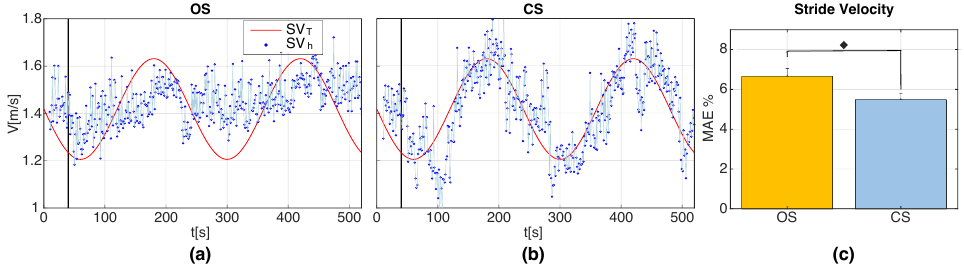
Figure 9. ( a , b ) SV h for a representative participant for the two stimulation methods, OS and CS, during S3. The black vertical line represents the time at which the stimulation engine was activated during the walking task; ( c ) Group averages of the percentage mean absolute errors (MAE%) of SV induced by OS and CS during S3. MAE% values are computed with respect to the time-varying target values SV T ( t ) . Error bars indicate ± 1SE. • indicates p < 0.05.